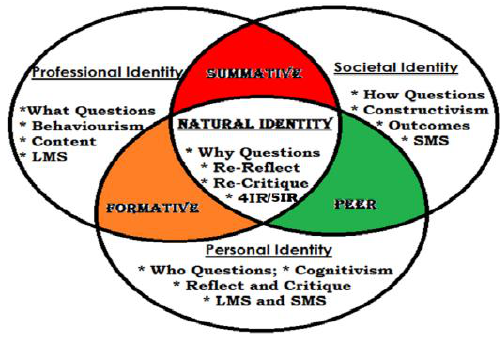
Figure 1: Natural Identity framework; Source: Khoza (2021b, p.